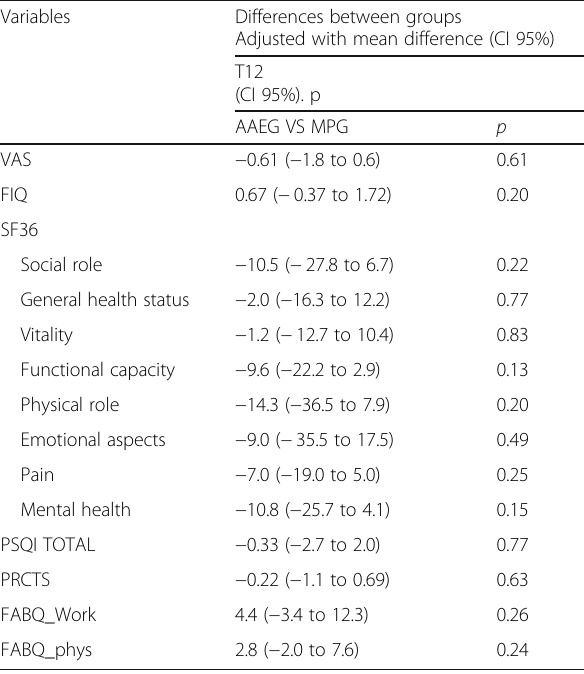
Table 3 Differences among T12 assessment groups for all analyzed variables Variables Differences between groups Adjusted with mean difference (CI